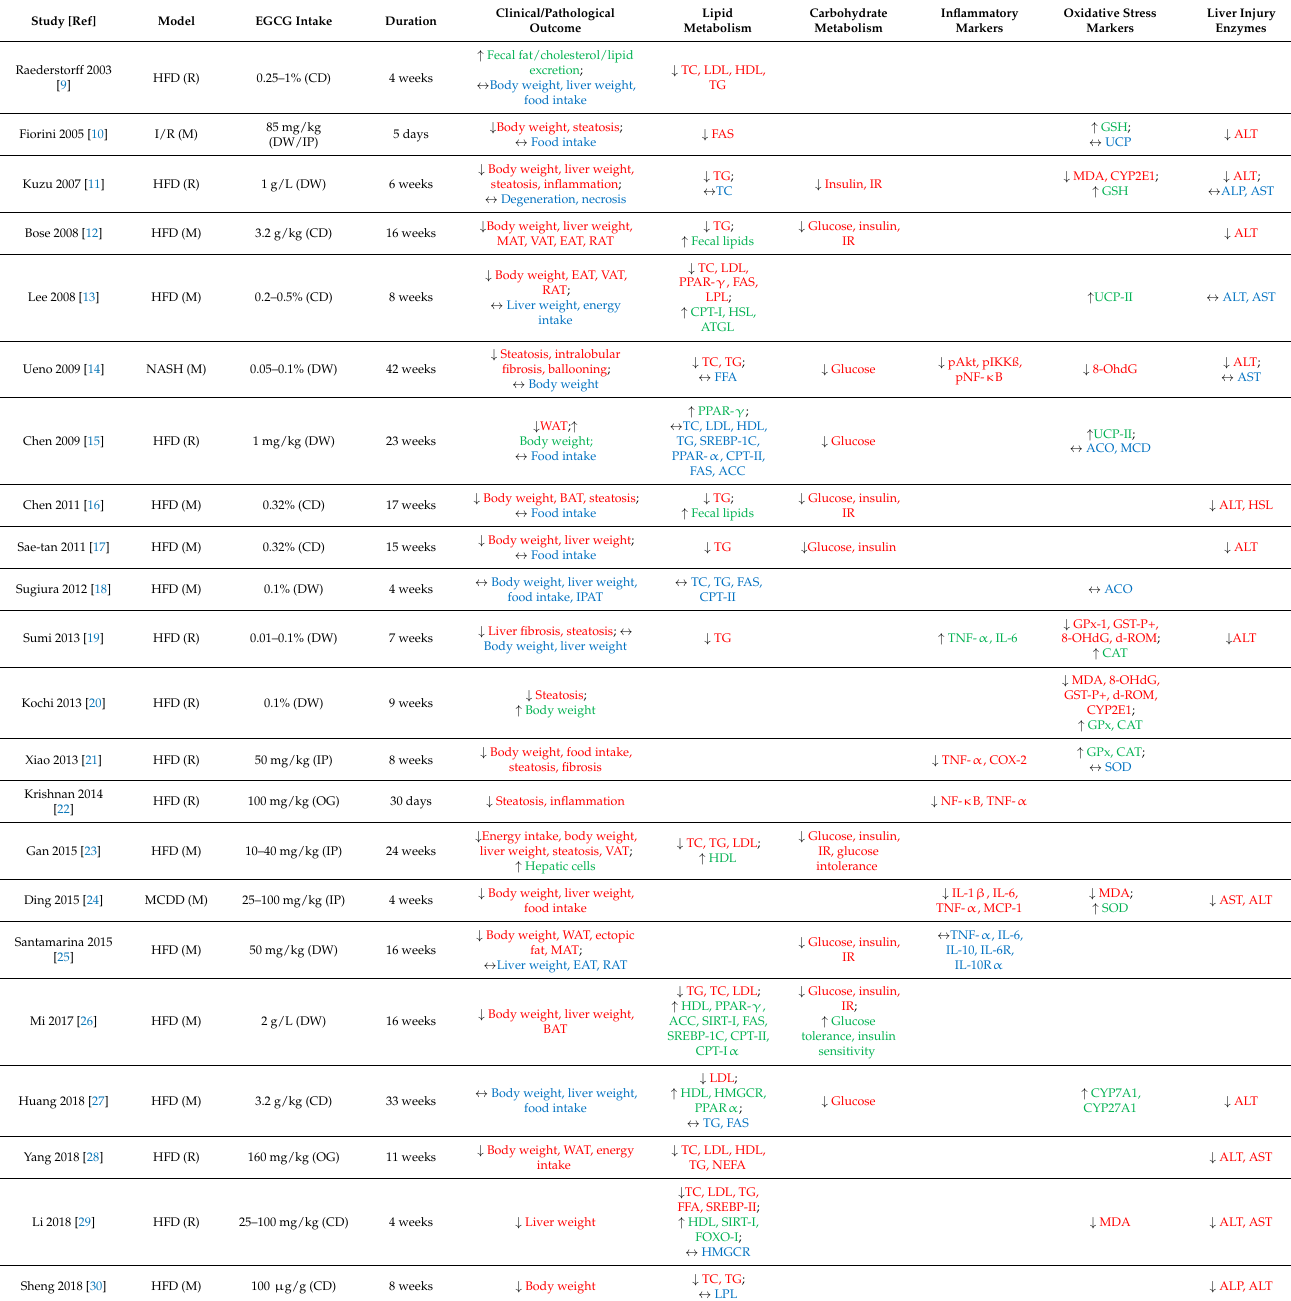
Table 1. Clinical Efficacy of EGCG Supplementation in Rodent